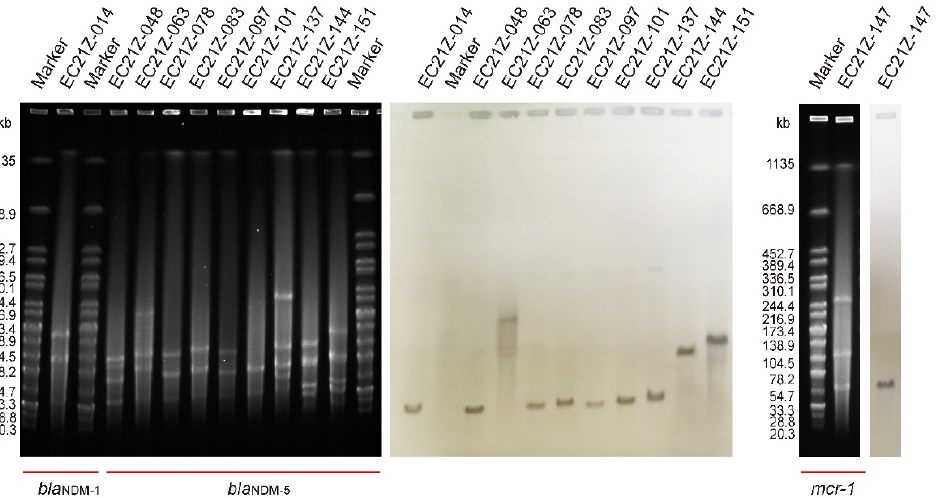
Figure 1. S1-PFGE and Southern blot of bla NDM-1 -, bla NDM-5 -, and mcr-1 -bearing E. coli strains ( n = 11).